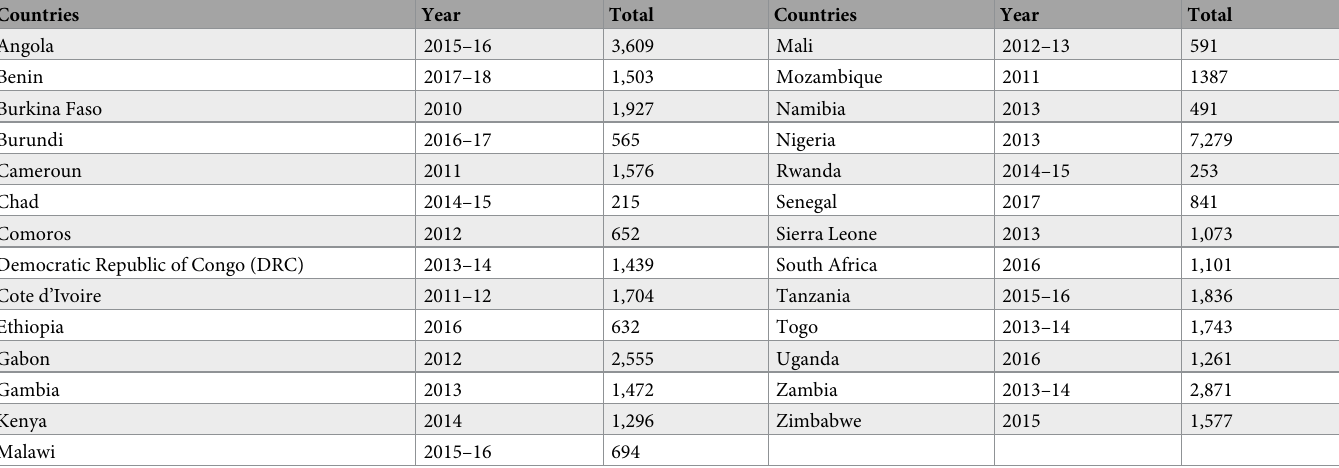
Table 1. Countries, sample sizes, and timing of the DHSs used in the